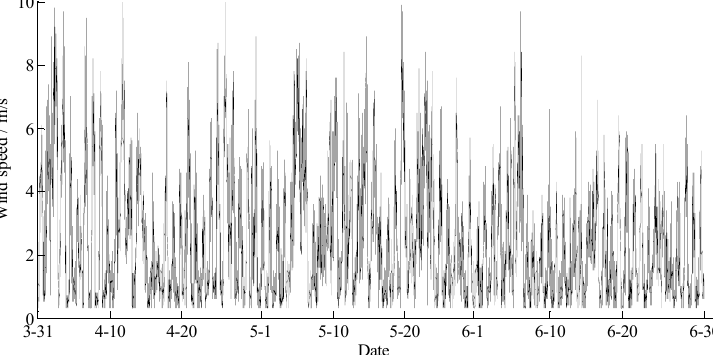
Figure 15. The curve of the wind speed in Hulun Buir.